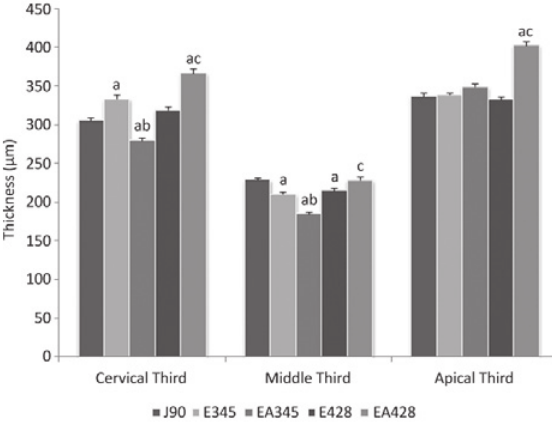
Figure 2 - Thickness of periodontal ligament (µm) in cervical, middle and apical thirds of the root observed in groups: J90 (90-day-old young rats), E345 (345-day-old aged rats), EA345 (345-day-old aged rats treated with ascorbic acid since 90-day-old), E428 (428-day-old aged rats) and EA428 (428-day-old aged rats treated with ascorbic acid since 90-day-old). n = 5 rats per group. a P < 0.05 when compared to group J90, b P < 0.05 when compared to group E345, c P < 0.05 when compared to group E428.